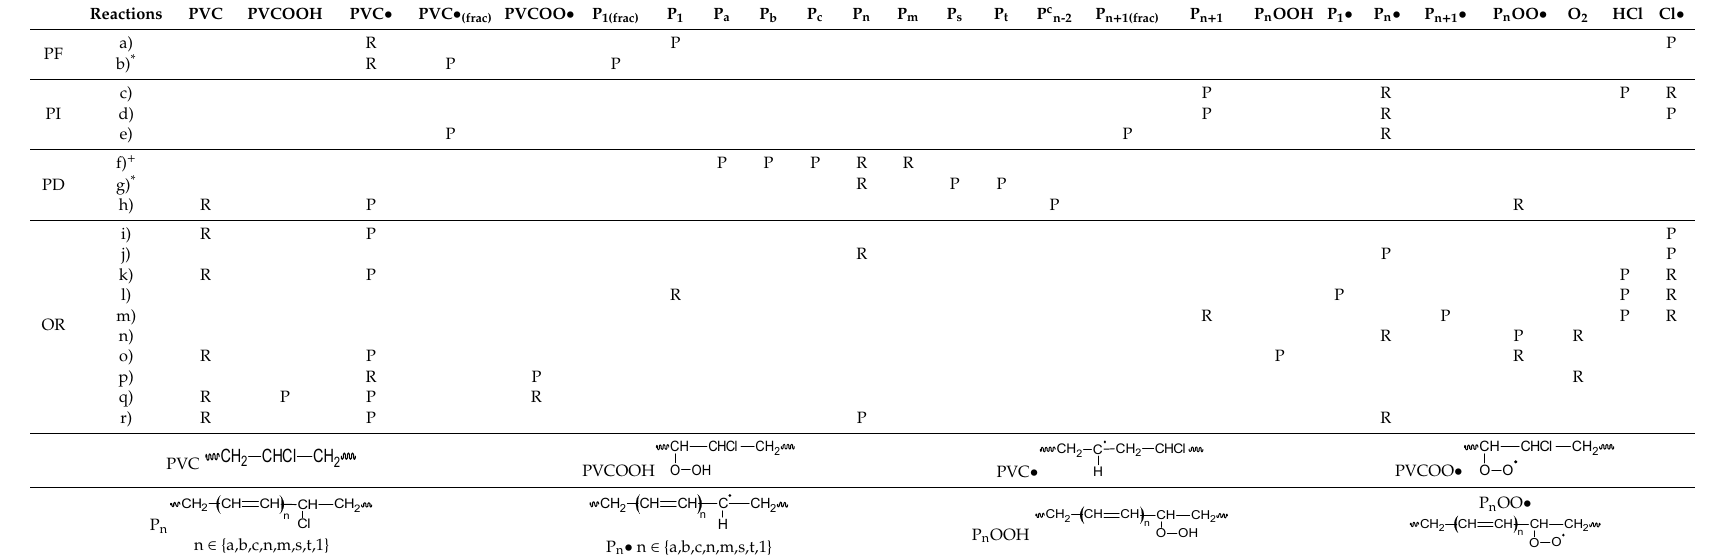
Table 1. Degrading reactions that a ff ect the polyene accumulation behavior on poly(vinyl chloride) (PVC) formulations being photo-thermally oxidized. Reactions